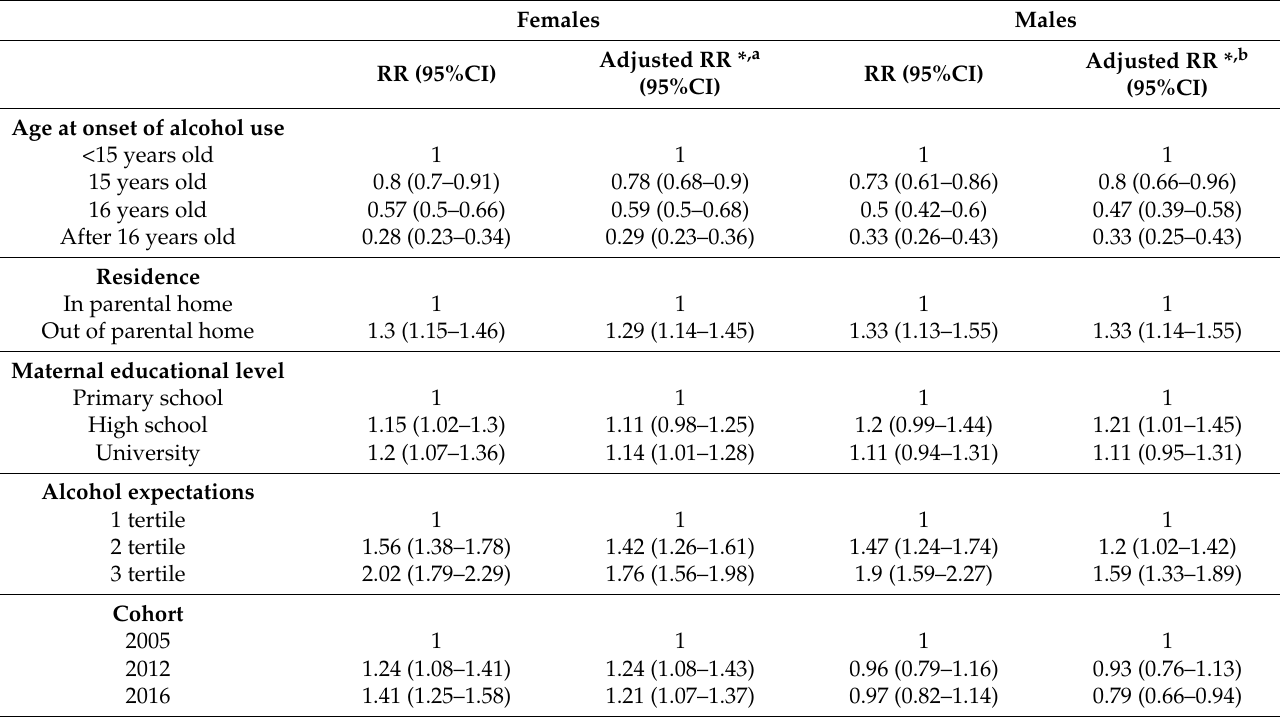
Table 5. Influence of explanatory factors in third domain (alcohol harm) of AUDIT test score by gender. Negative binomial